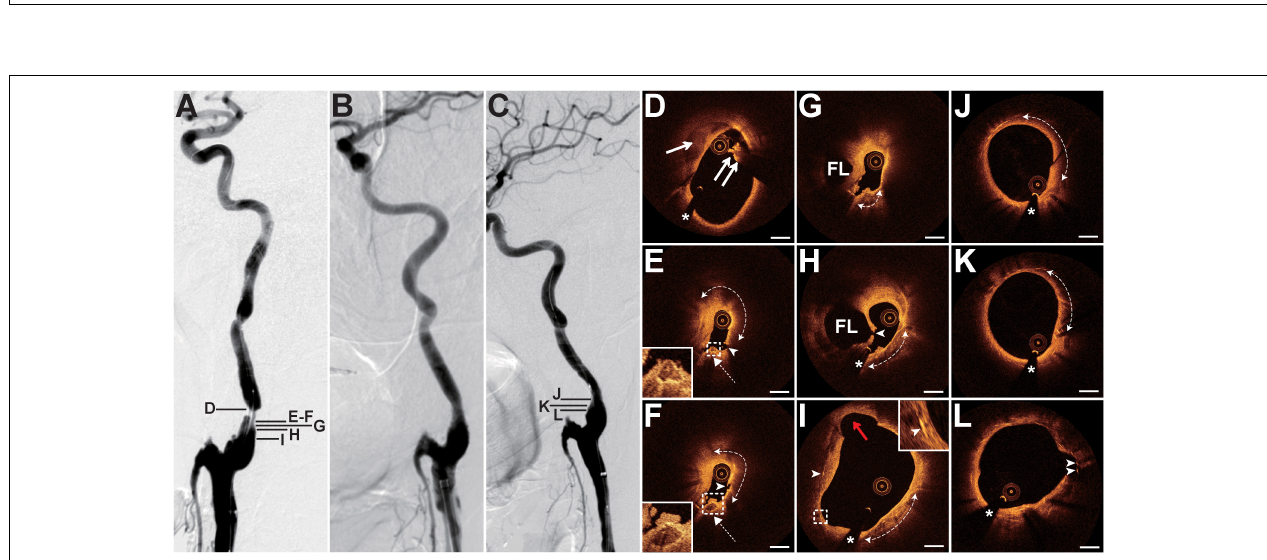
FIGURE 3 | DSA and OCT findings of the LICA lesion. Case 3. (A) The angiogram before stenting showed severe stenosis with an irregular surface at the LICA C1 segment. (B) The angiogram after stenting. (C) The angiogram at a 13-month follow-up revealed no in-stent restenosis. (D) The crescent-shaped intramural hematoma (arrow) and the intraluminal thrombus (double arrow). (E,F) Adjacent OCT images. Image (E) represents the image with the minimum lumen. The lipid-rich plaque (dashed curve with arrows) with plaque rupture (arrowheads) and adjacent ruptured calcific nodule (dashed arrows) with overlying thrombus were detected. (G,H) The double-lumen and the fenestration (arrowhead) between the true lumen and the false lumen (FL). The calcification (dashed curve with arrows) with overlying thrombus. (I) The cavity formation (red arrow), cholesterol crystals (arrowheads), and calcification (dashed curve with arrows) were observed. (J–L) Thirteen-month follow-up OCT images. Image (J) represents the image with the minimum lumen. Homogeneous neointima and signal-poor regions around stent struts (dashed curve with arrows) were detected. There were uncovered stent struts (arrowheads) in the cavity. Image (L) corresponds to image (I) . Scale bars represent 1 mm. Asterisks denote guide-wire artifact. DSA, digital subtraction angiography; LICA, left internal carotid artery; OCT, optical coherence tomography.